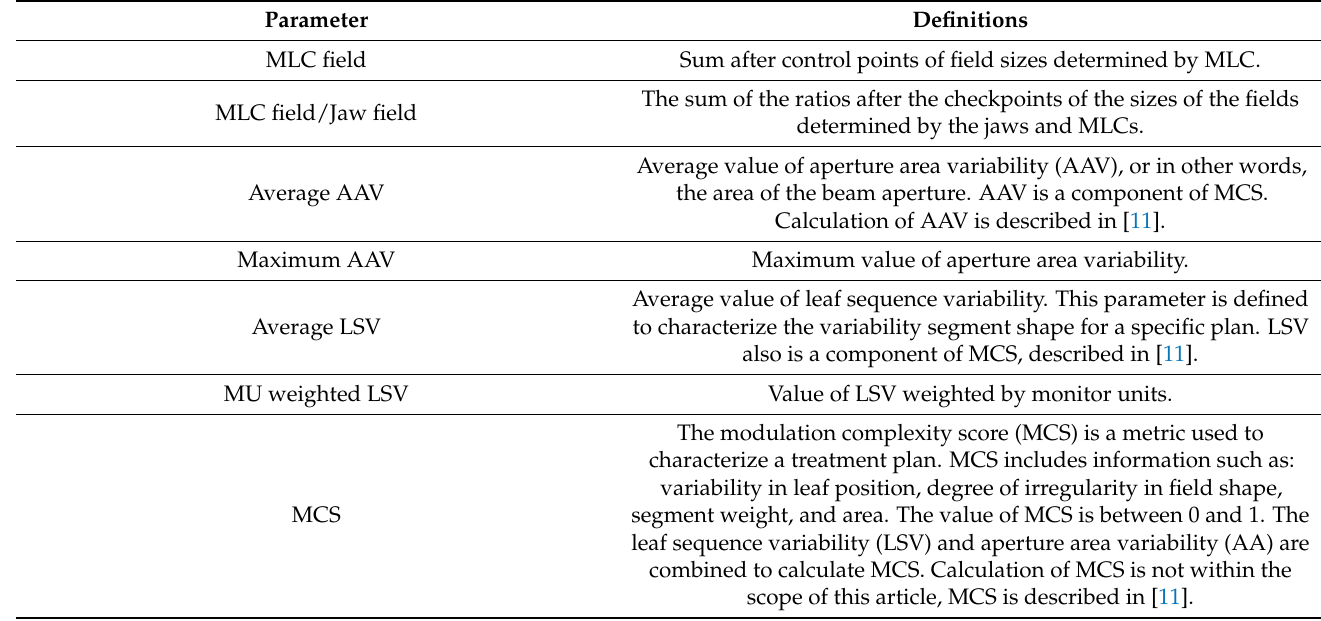
Table 1. Significant parameters included in the machine learning